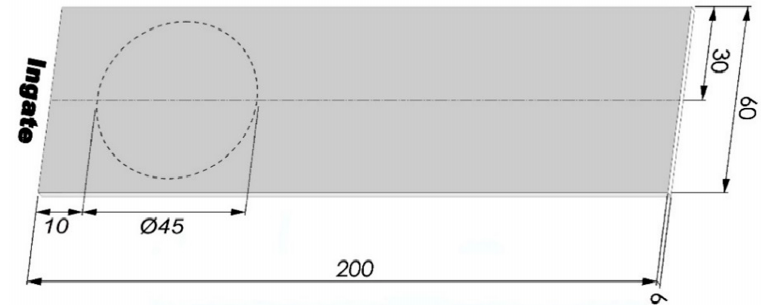
Figure 1. Die cast plate showing the investigated location (dimensions in mm).